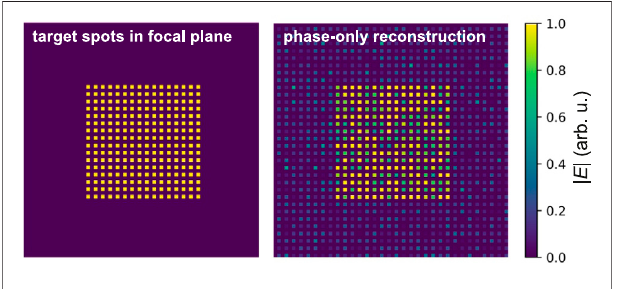
FIGURE 2 | Artefacts related to phase-only light shaping. Field modulus ofatargetpattern(left)andthesimulatedpatternreconstructedbyphase-only wavefront shaping in the Fourier plane (right), illustrating introduced